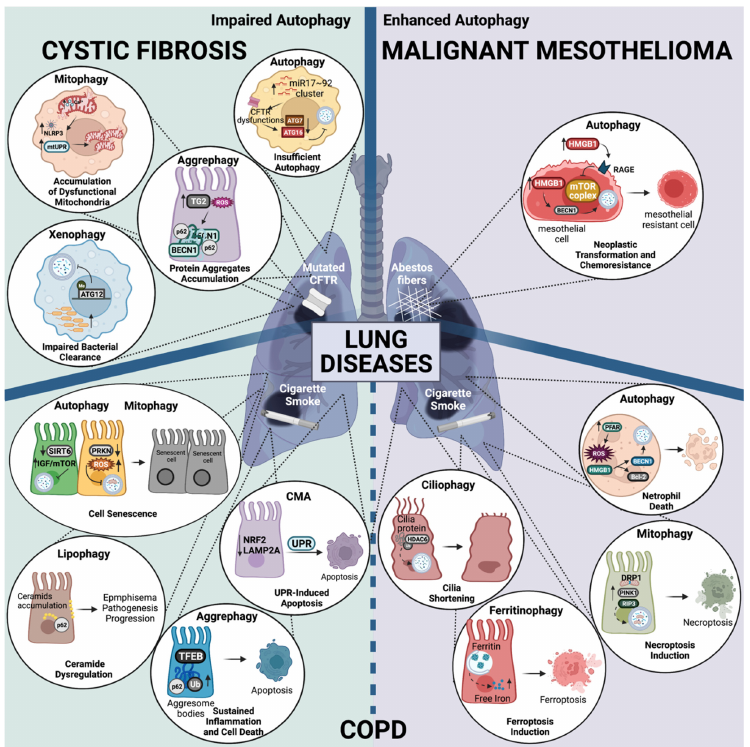
Figure 3. Autophagy dysregulation in lung disease progression. Representation of the main molecular mechanism underlying the role of autophagy pathway dysregulation, which is associated with Cystic Fibrosis (CF), Malignant Mesothelioma (MM), and Chronic Obstructive Pulmonary Disease COPD. On the left (green rectangle), the impairment of different autophagy pathways contributes to the exacerbation of pulmonary inflammation in CF (top) and COPD (bottom). Deficit in these degradation pathways lead to the accumulation of degradation products, which ultimately leads pathogenesis progression. On the right (violet rectangle), the enhancement of different autophagy pathways linked to COPD (bottom) and MM (top) are also illustrated inside the zoom circles. Although COPD progression has been associated with impaired autophagy, enhanced autophagy pathways have also been associated with the worsening of the disease. Increased autophagy in MM has been associated with neoplastic transformation and chemoresistance. The main cause of each disease is also reported: mutation in CFTR for CF, asbestos fibers for MM, and cigarette smoke for COPD. All the altered autophagy mechanisms underlying the above-mentioned lung diseases are extensively described in the main text. Created with BioRender.com.